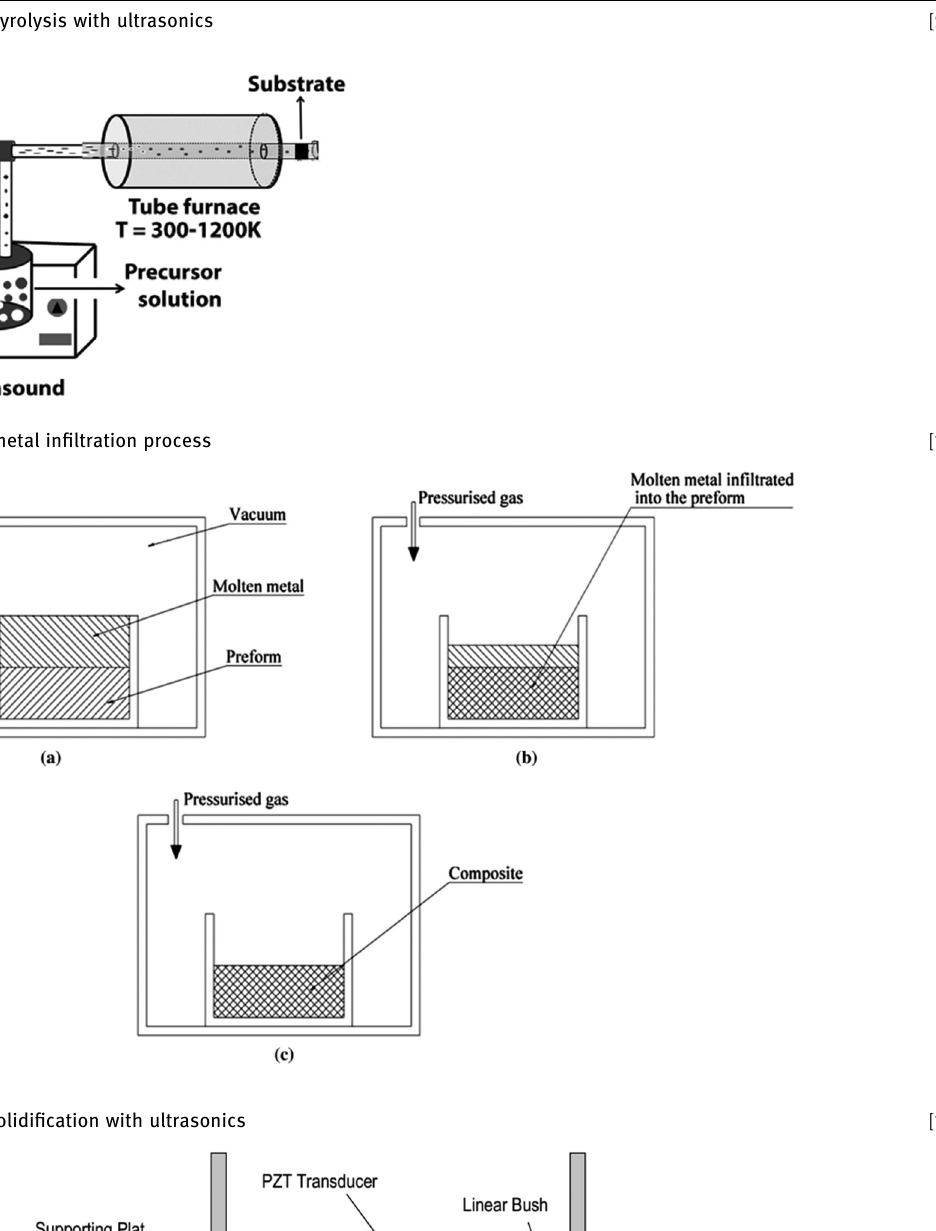
Table 11: Various processing method schematics of MMNCs. Processes for which schematics are not included are either chemical reactions or do not have any processing